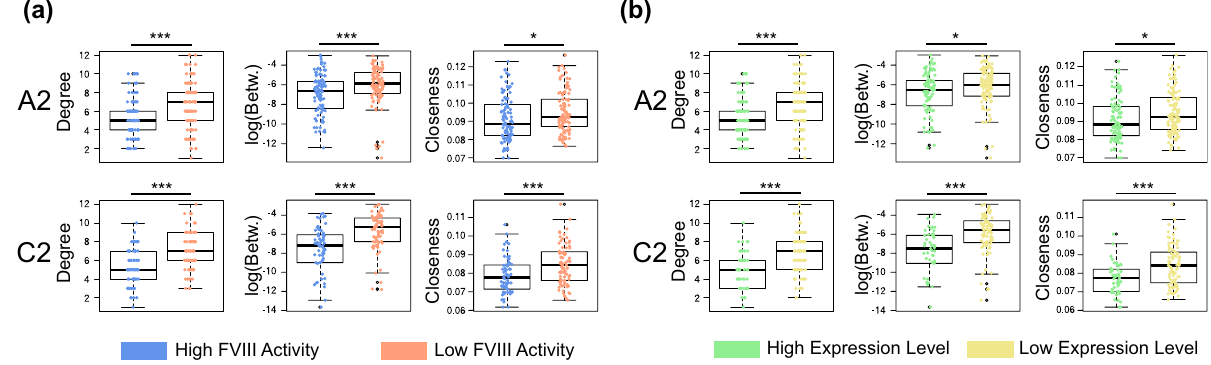
Figure 2. Centrality measures and mutagenesis results. ( a ) Alanine mutations on residues of the A2 and C2 domains that are more central in the FVIII RIN caused a reduction of the FVIII co-factor activity, measured by a chromogenic assay measuring thrombin formation 6,7 . ( b ) A similar effect is observed for the secretion and expression of the mutant constructs; here mutations at the central residues show a significant reduction in the expression/secretion levels, measured using the ELISA assay 6,7 . In all cases, the boxplots depict the median (center line), the first and third quartiles (lower- and upper-bounds), and 1.5 times the inter-quartile range (lower- and upper whiskers). Each dot in the plot is an amino acid mutation (i.e., an in vitro alanine mutant construct). Unpaired, two-sided Wilcoxon test (***Indicate p-values < 0.001; **p-value < 0.01; *p-value <